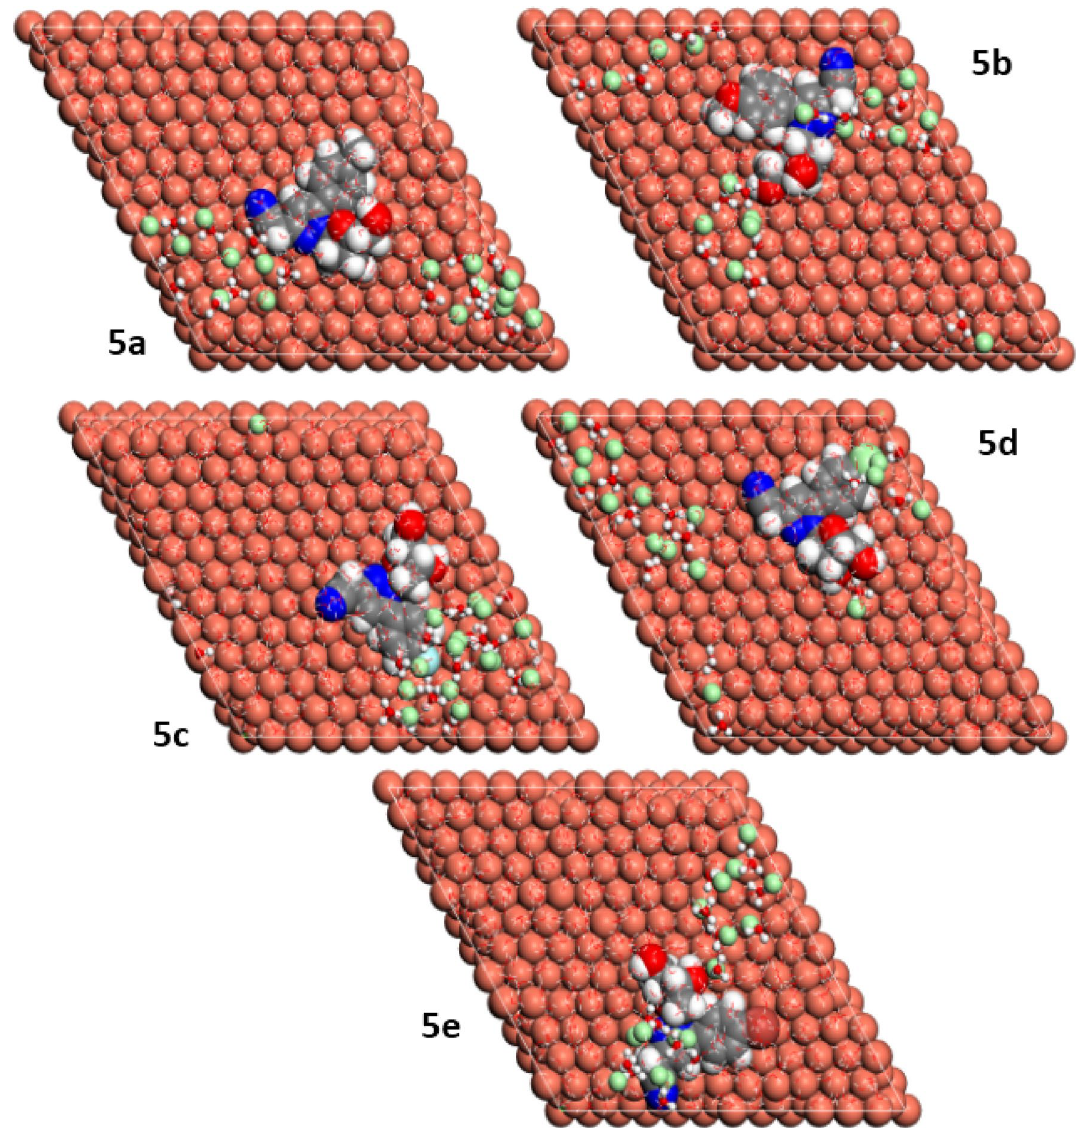
Figure 10. Lowest energy MD top view of 5a – e onto Cu(111)